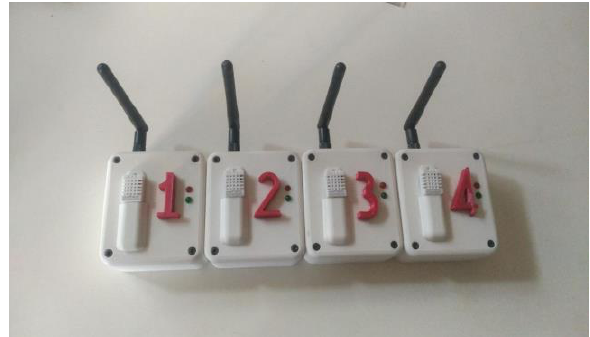
Figure 2.2. Actual view of these modules.